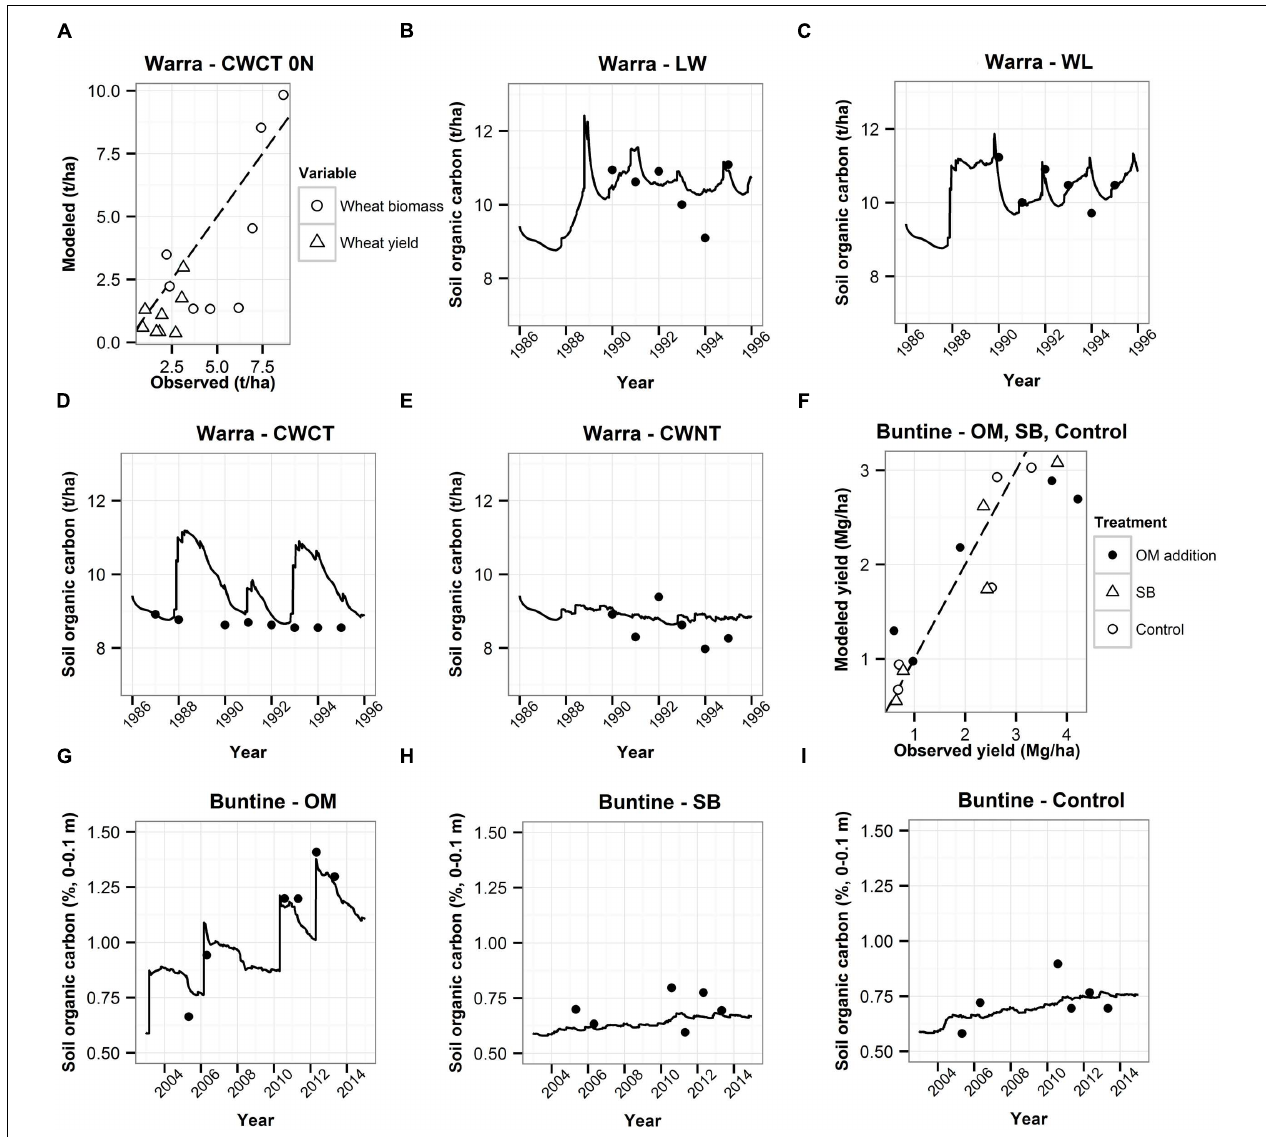
FIGURE 3 | Modeled and observed plant biomass and yields for Warra (A) and modeled and observed yields for Buntine (F). Modeled (lines) and observed (dots) soil organic carbon (SOC; 0–0.1 m) at Warra (B–E) and Buntine (G–I) under different agricultural practices over time. For Warra, the